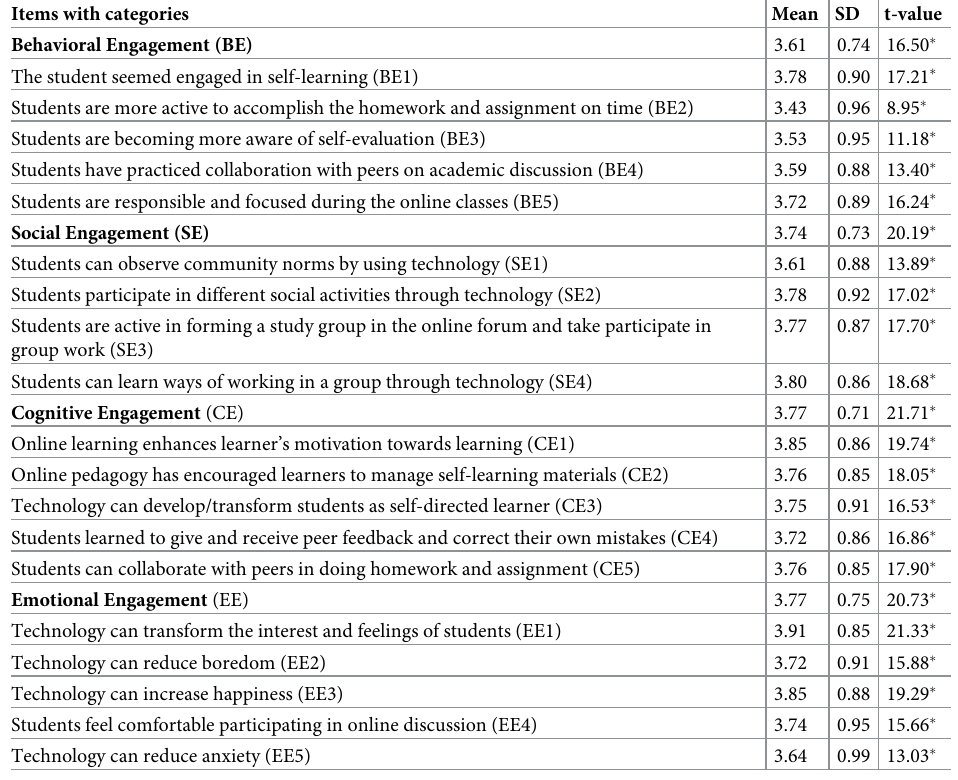
Table 2. Result of items and dimension wise descriptive statistics with reliability and validity (n =